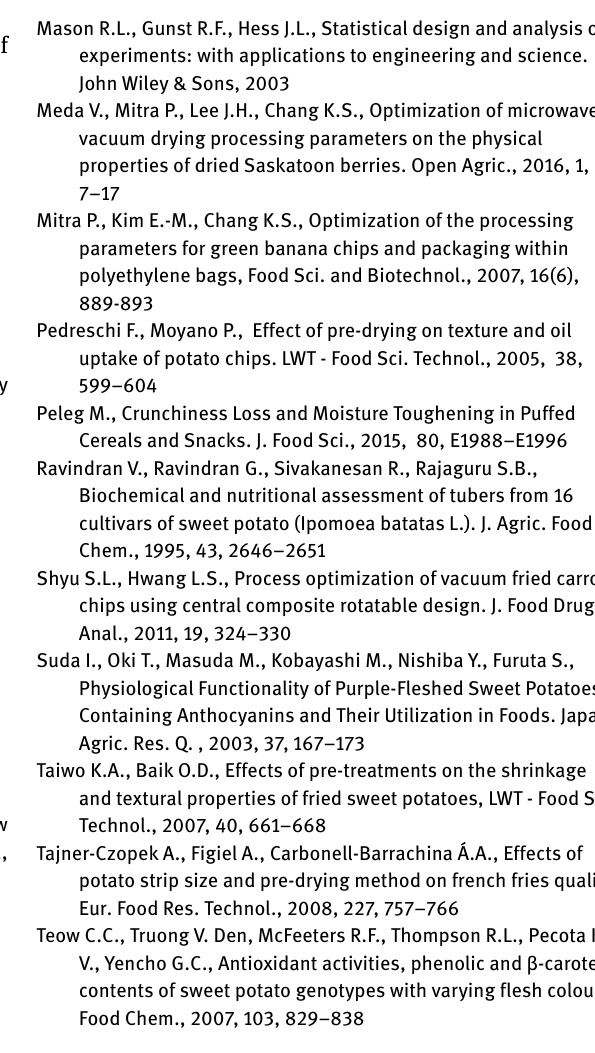
Figure 4: Graphical optimization (yellow shaded area) of pre-drying time (min), frying temperature (°C) and frying time (min) for the moisture content, water activity, oil content, color (L value and total color difference), hardness and crispness of the sweet potato chips.